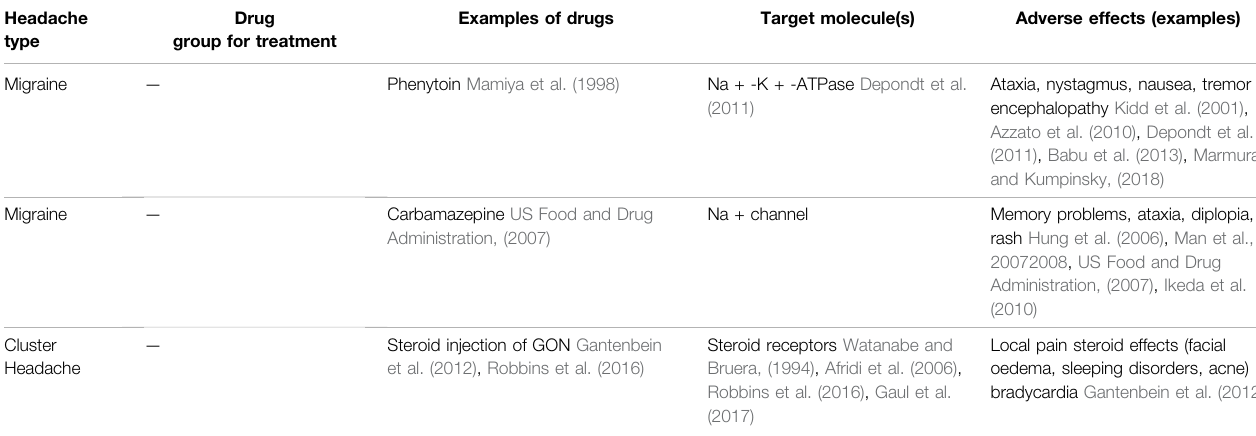
TABLE 2 | ( Continued ) Treatment principles of primary headache disorders — treatment options for